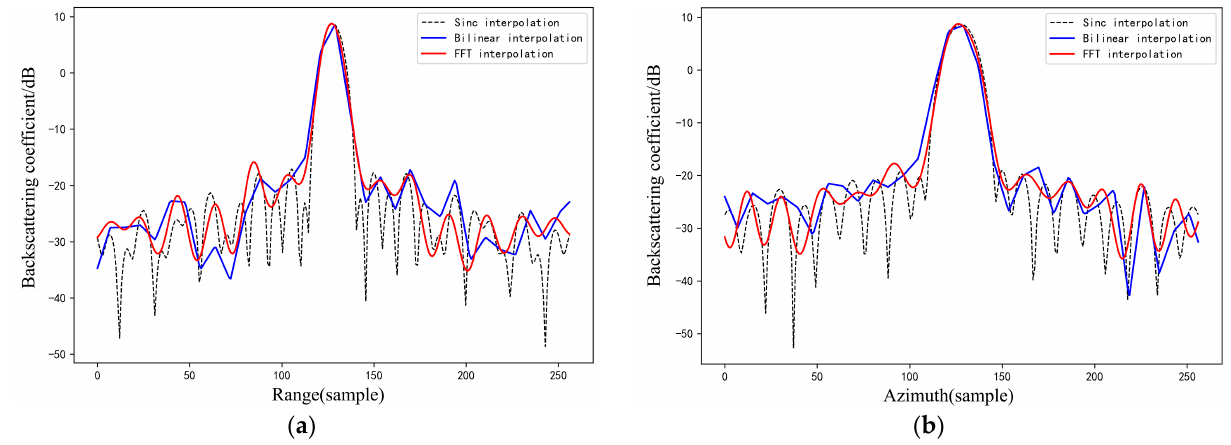
Figure 7. Interpolation results along range and azimuth direction using Sinc, Bilinear and FFT methods for point target (taking CR-1 as an example). ( a ) Interpolation results along range direction. ( b ) Interpolation results along azimuth direction.